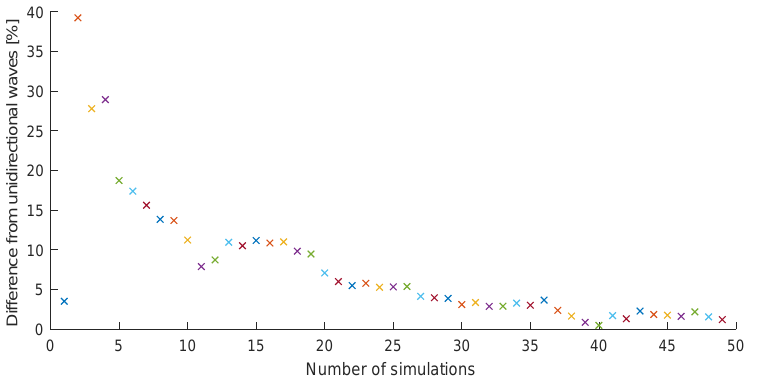
Figure 8. Convergence of the normalized energy absorption with number of simulations. For each simulation S , the average over the 1: S th simulations is shown for the average of the energy absorption as in Equation (43), corresponding to the park of 16 WECs in Figure 7. Hence, Figure 7c, which is the average over all 50 simulations, corresponds to the last point in this figure.